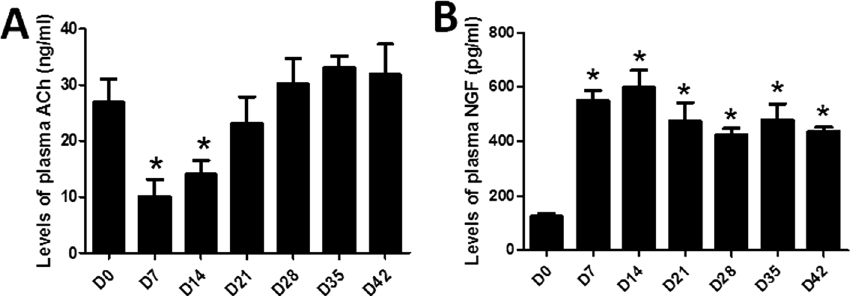
Figure 5. Levels of plasma acetylcholine (ACh) and nerve growth factor (NGF) in DSS-induced colitis rats. * P < 0.05 compared with Day 0. (N =